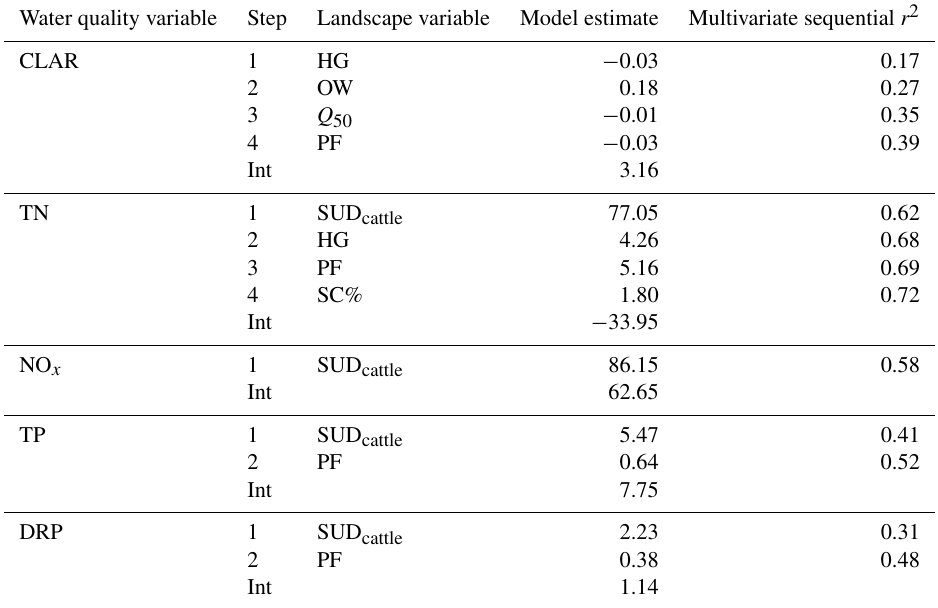
Table 8. Stepwise regressions of water quality variables (median values) on landscape descriptors (forward selection, p <0.05). Signs of coefficients indicate whether the relationship is proportional ( + ) or inverse ( − ). Int is model intercept. Scatter plots that characterize the primary and secondary explanatory variables are displayed in Fig.